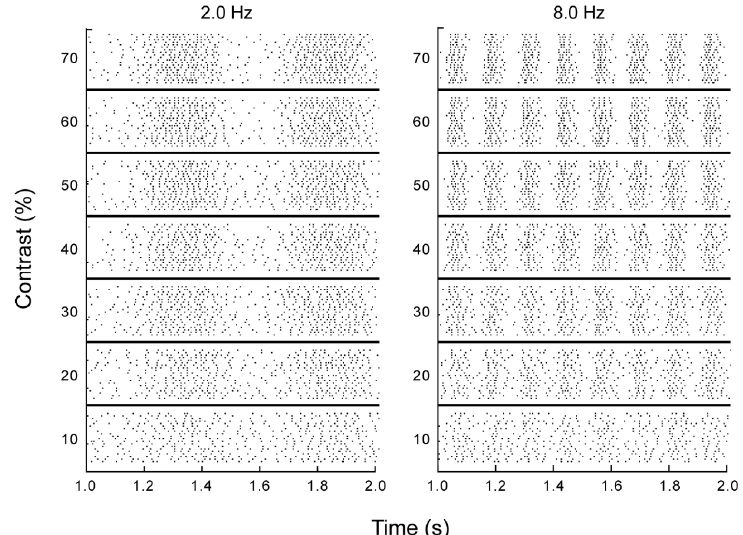
Figure 1. Retinal ganglion cell responses to drifting sinusoidal grating stimuli. Raster plot of a 1 second section of the response of a single retinal ganglion cell to drifting sinusoidal grating stimuli, varying in contrast (10%–70%) and temporal frequency (left 2.0; right 8.0 Hz). Each dot in the display represents a spike. Each line represents the response to a single presentation of the stimulus. Stimuli were presented randomly interleaved, and repeated a minimum of 20 times.